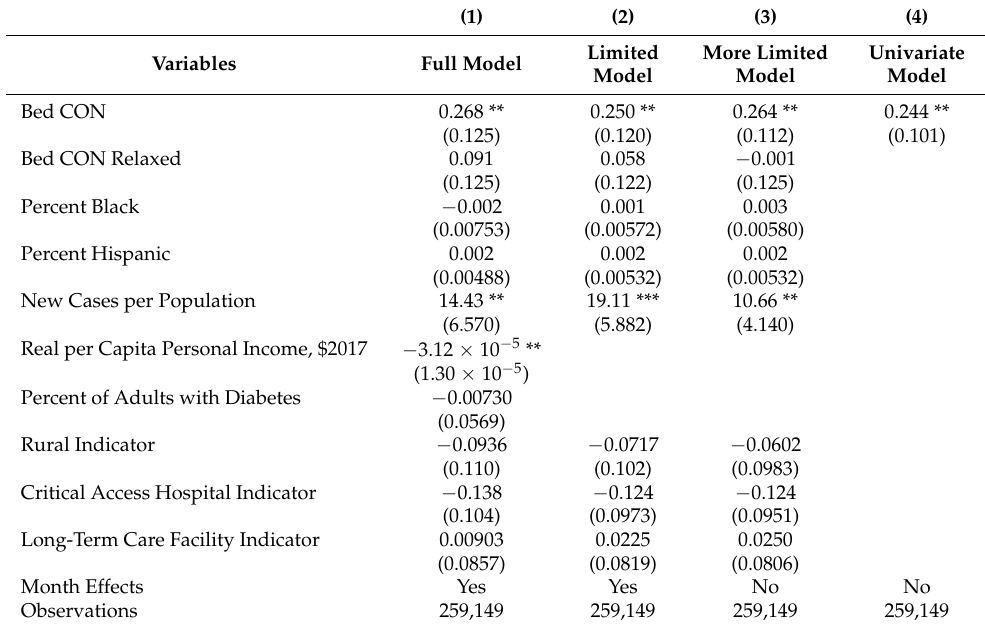
Table 7. Modeling the Likelihood That a Hospital Will Use 100 Percent of Its